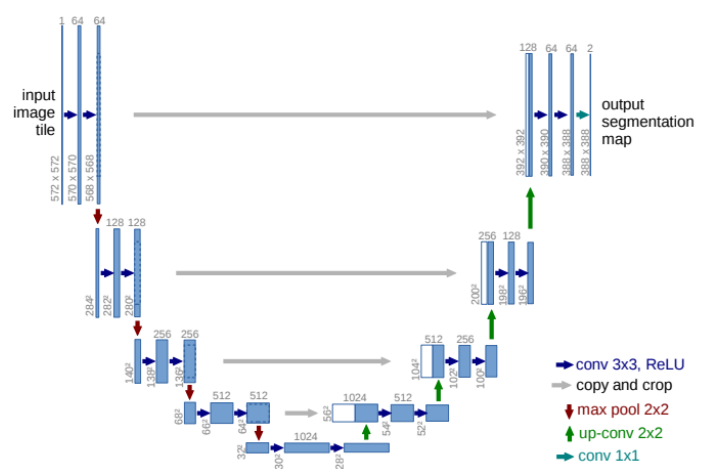
Figure 8. U-net architecture (example for 32 × 32 pixels in the lowest resolution). Each blue box corresponds to a multi-channel feature map. The number of channels is denoted on top of the box. The x – y -size is provided at the lower left edge of the box. White boxes represent copied feature maps. The arrows denote the different operations [49].